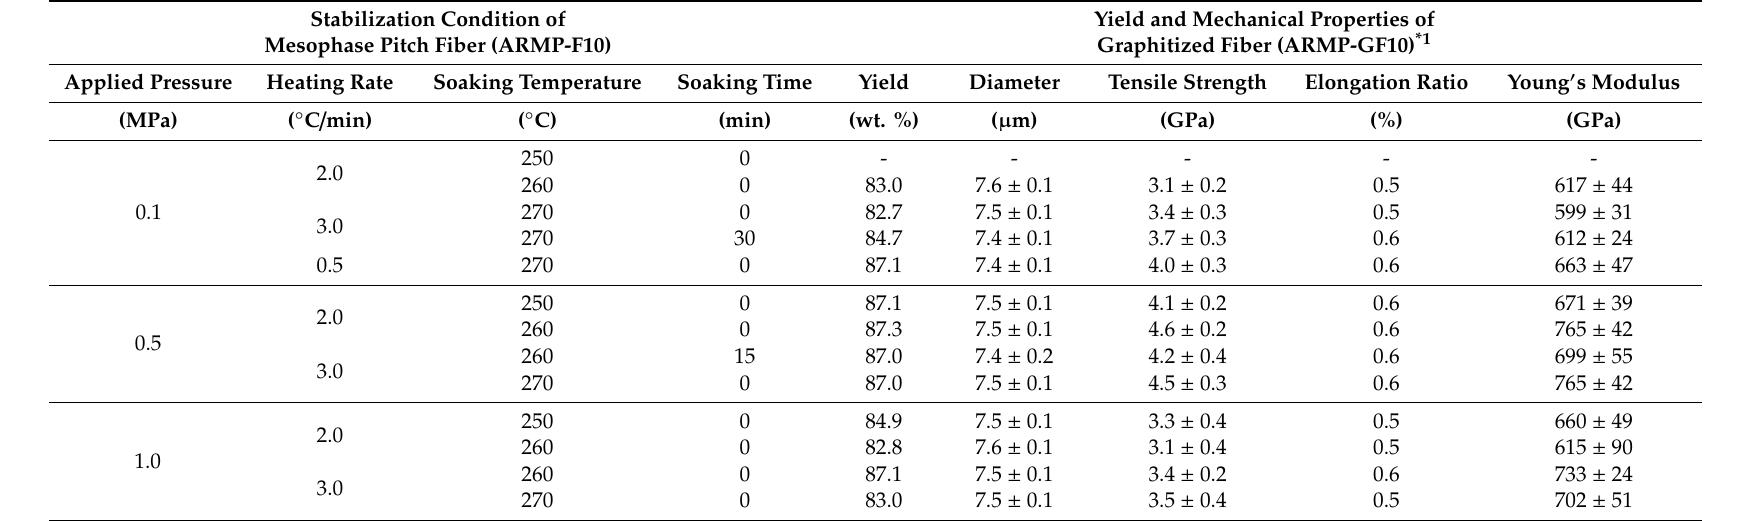
Table A3. The yields and mechanical properties of graphitized